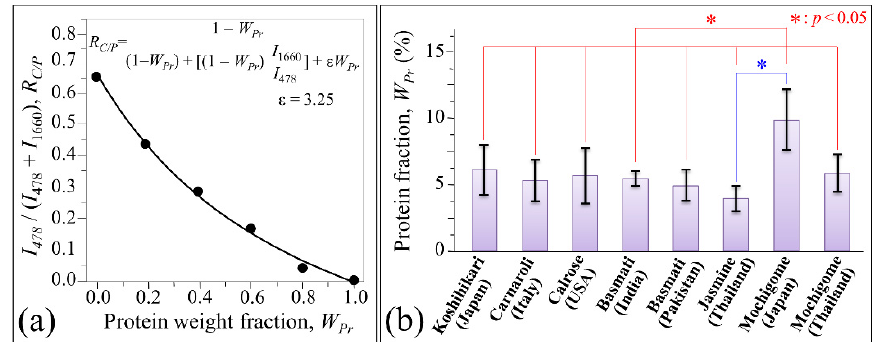
Figure 8. ( a ) Calibration plot of the Amide I Raman intensity ratio, R C/P = I 478 /( I 478 + I 1660 ), vs. protein weight fraction, W Pr (least-square fitting equation in inset); ( b ) protein weight fraction computed from Raman experiments for the eight investigated rice (cf. labels).